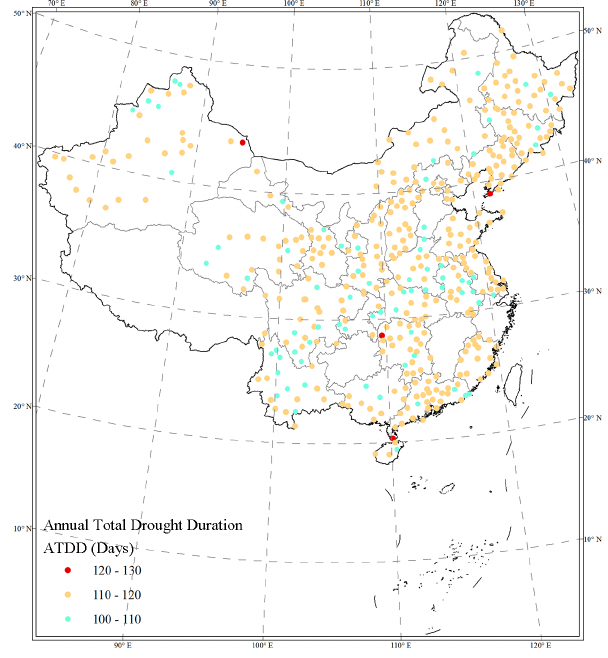
Figure 4. The spatial distribution of ATDD across mainland China.